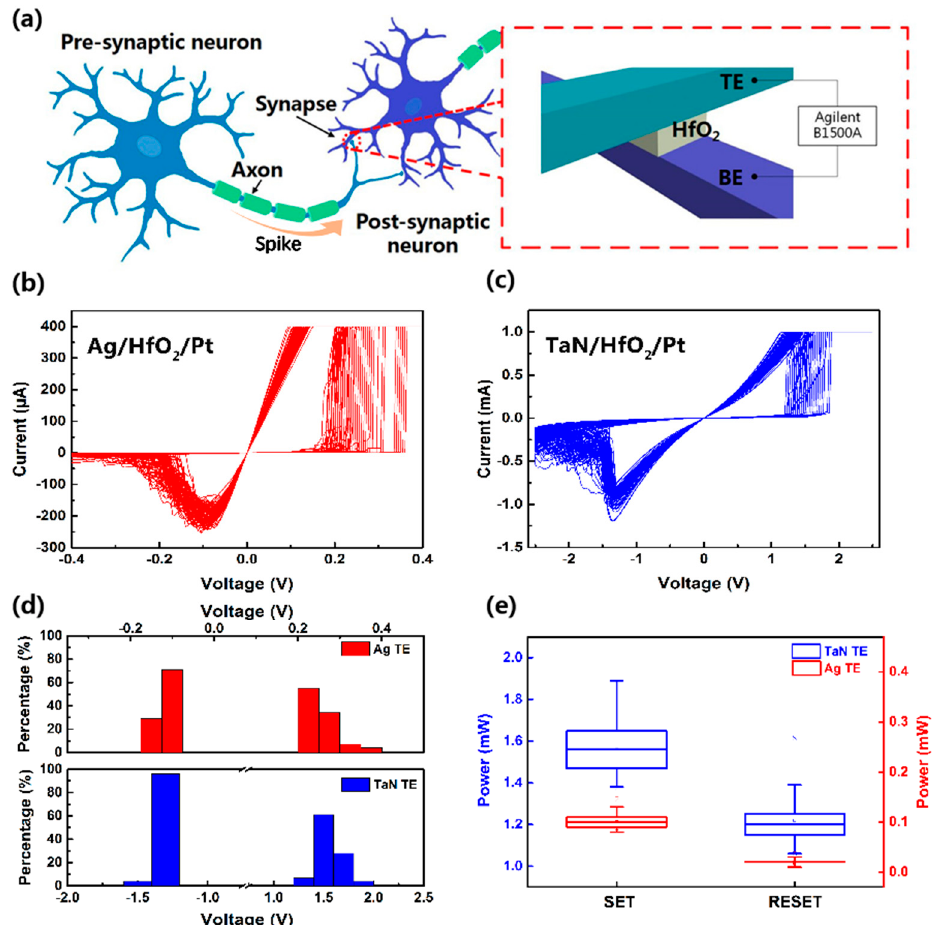
Figure 1. ( a ) Illustration of biological synapse connecting two neurons and schematic structure of the equivalent HfO 2 -based synaptic device; ( b ) repetitive I-V characteristics in Ag/HfO 2 /Pt devices; and ( c ) TaN/HfO 2 /Pt devices; ( d ) histograms of the RESET/SET operating voltage in Ag/HfO 2 /Pt and TaN/HfO 2 /Pt devices during cycling test; ( e ) Statistical charts of the power consumption in Ag/HfO 2 /Pt and TaN/HfO 2 /Pt devices.